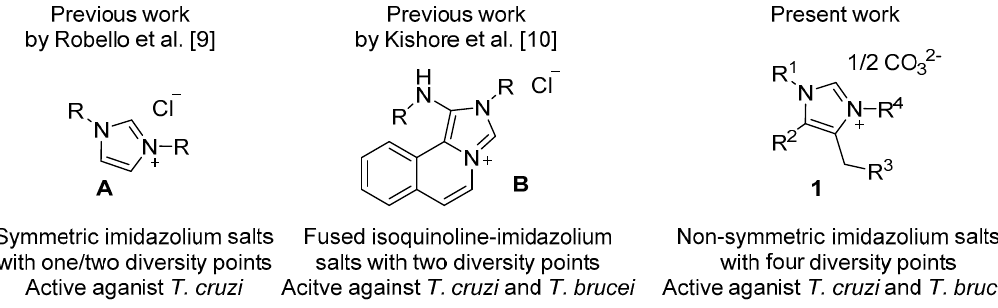
Figure 1. Structures of imidazolium salts active against Trypanosoma species: disubstituted imidazolium salts A [9], amino isoquinoline-imidazolium salts B [10], and the novel tetrasubstituted imidazolium salts 1 .